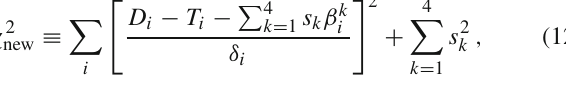
Fig. 2 The CLAS data compared with the nuclear-PDF predictions. Left panels: EPPS16 with (solid line) and without (dashed line) TMCs. Center panels: nCTEQ15. Right panels: TuJU19 with (solid line) and (cid:4)χ 2 , in turn, signifies a tension in the PDF fit between the new data and some other data in the original